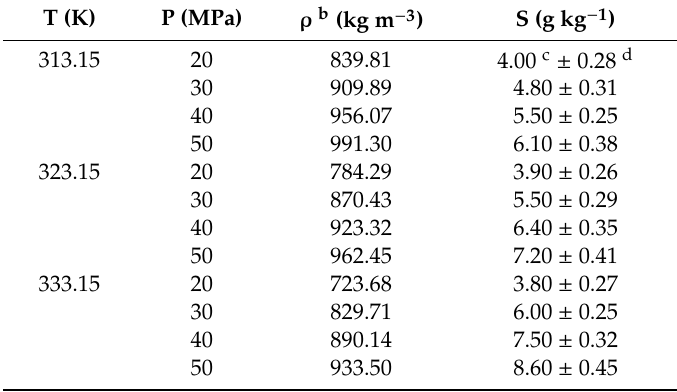
Table 2. Solubility (S) of paprika extract in supercritical carbon dioxide a